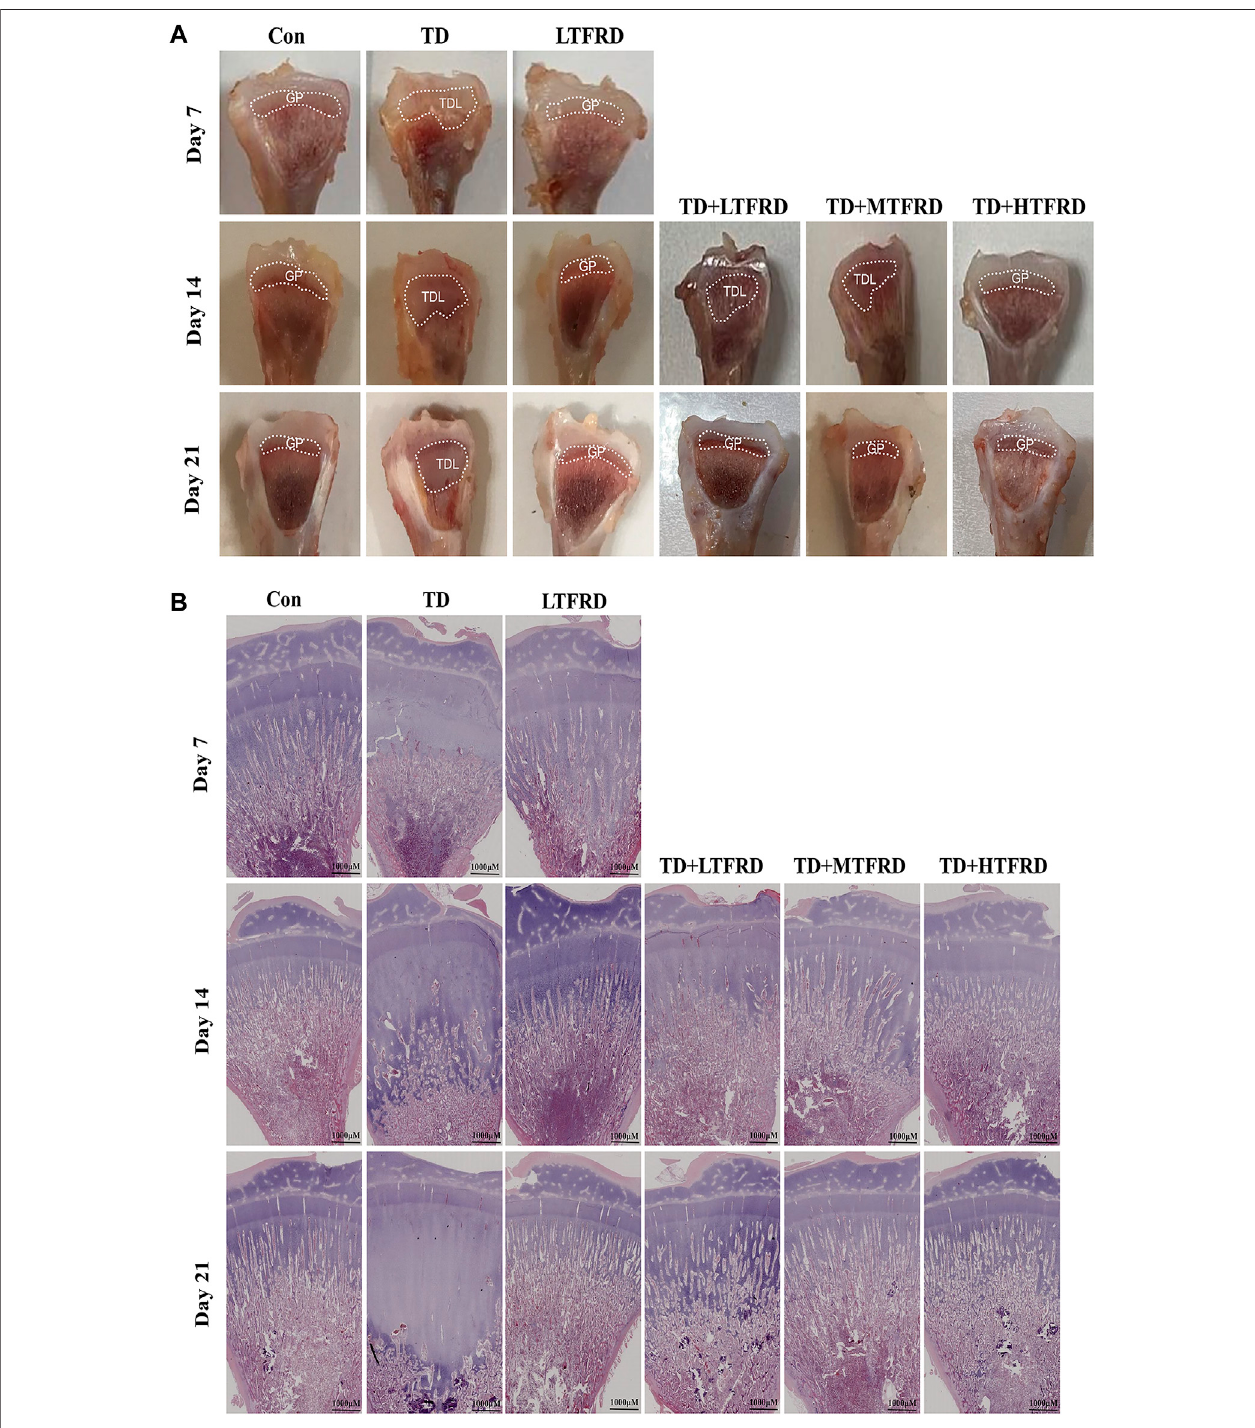
FIGURE 2 | Effects of TFRD on growth plate of tibia bone in TD broilers. (A) The morphology result of tibial growth plate. GP, growth plate; TDL, tibial dyschondroplasias lesion. (B) The HE staining observation result of tibial growth plate. Scar bar = 1,000 µm.